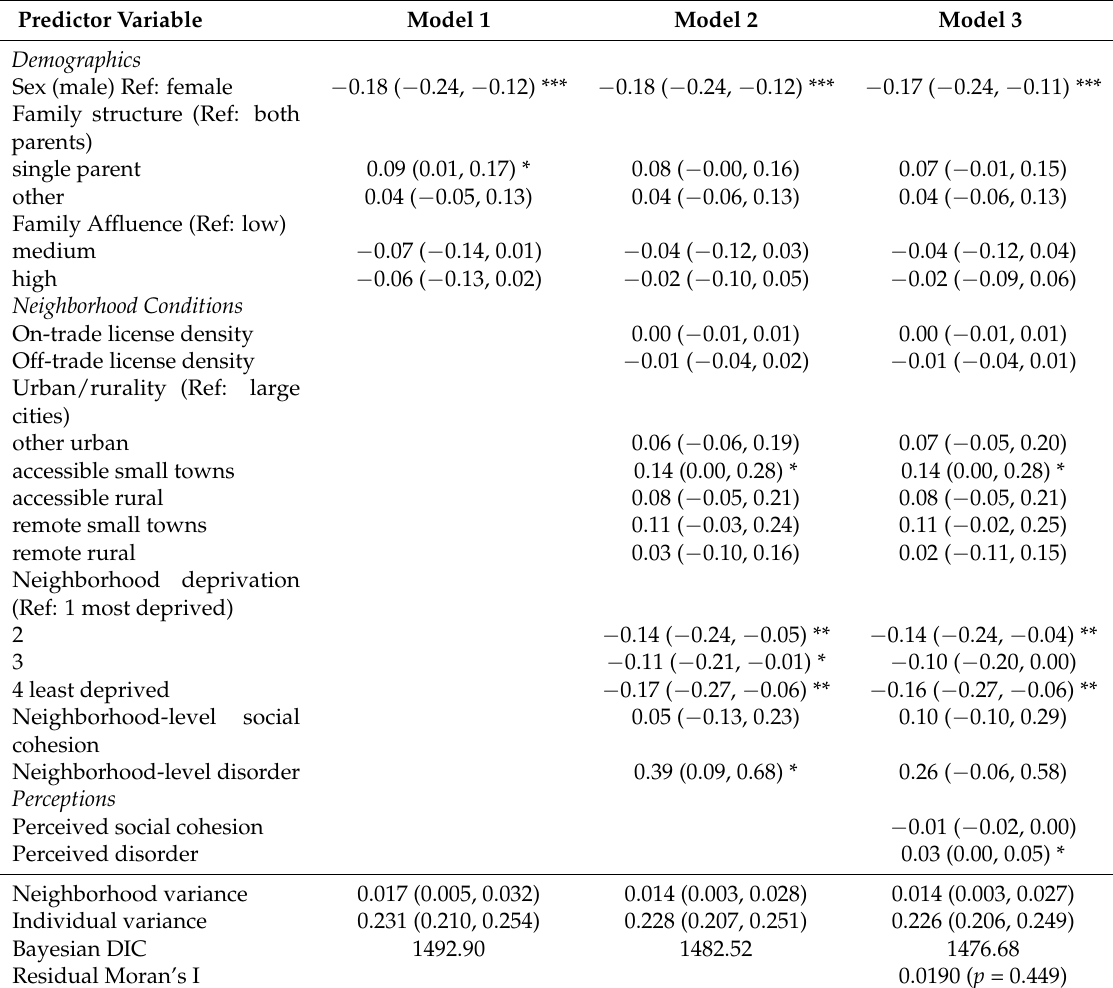
Table 3. Coping motives regressed on neighborhood and individual measures (95% credible intervals) n = 1046 (Intermediate Data Zones n =